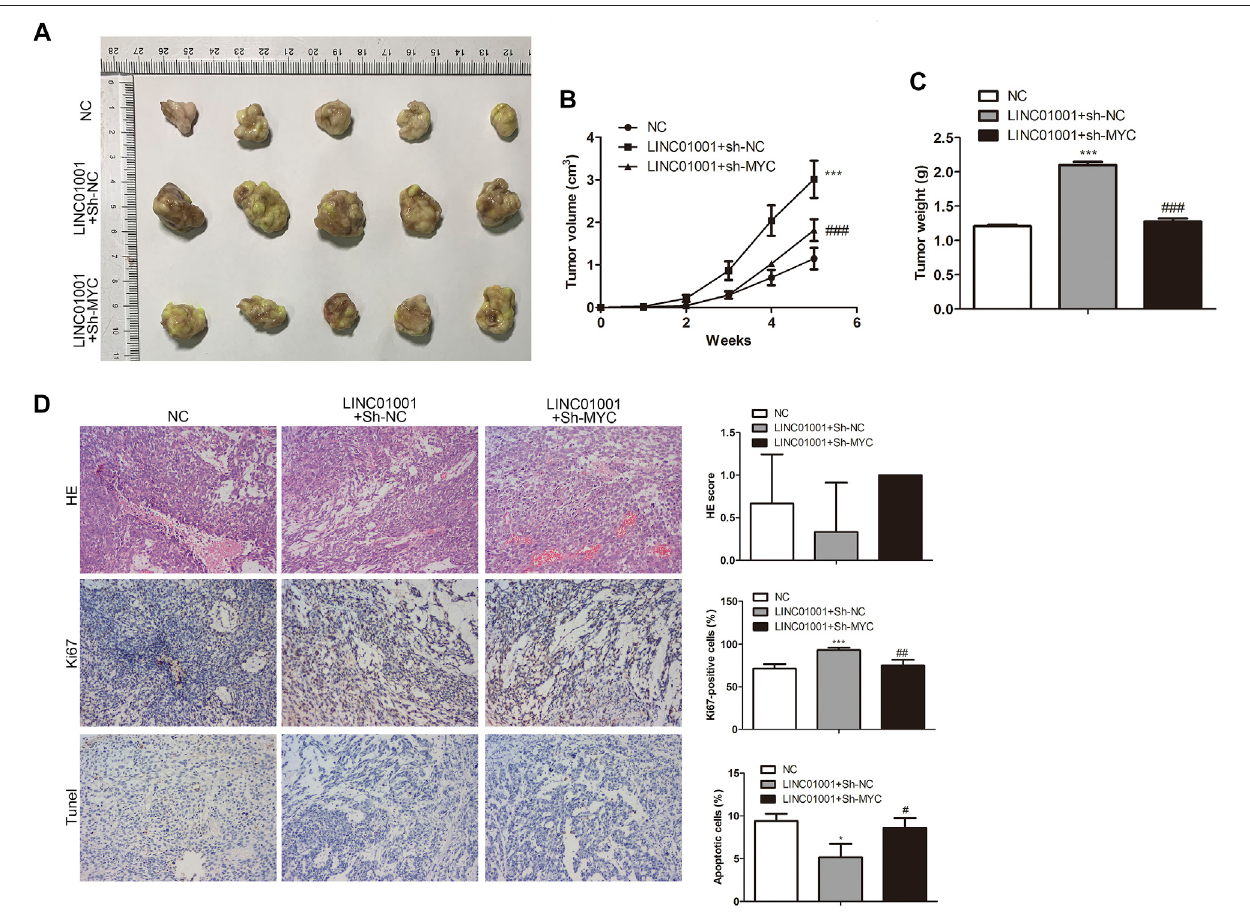
FIGURE 9 | LINC01001 overexpression increases crizotinib-resistance of NSCLC via MYC in vivo . (A) Tumor size. (B) Statistical analysis of tumor volume. (C) Statistical analysis of tumor weight. (D) H&E staining and IHC staining of Ki67 in tumor tissues. * p < 0.05, *** p < 0.001 vs NC group, # p < 0.05, ## p < 0.01, ### p < 0.001 vs LINC01001+sh-NC group. Error bars represent SD. Data represent three independent